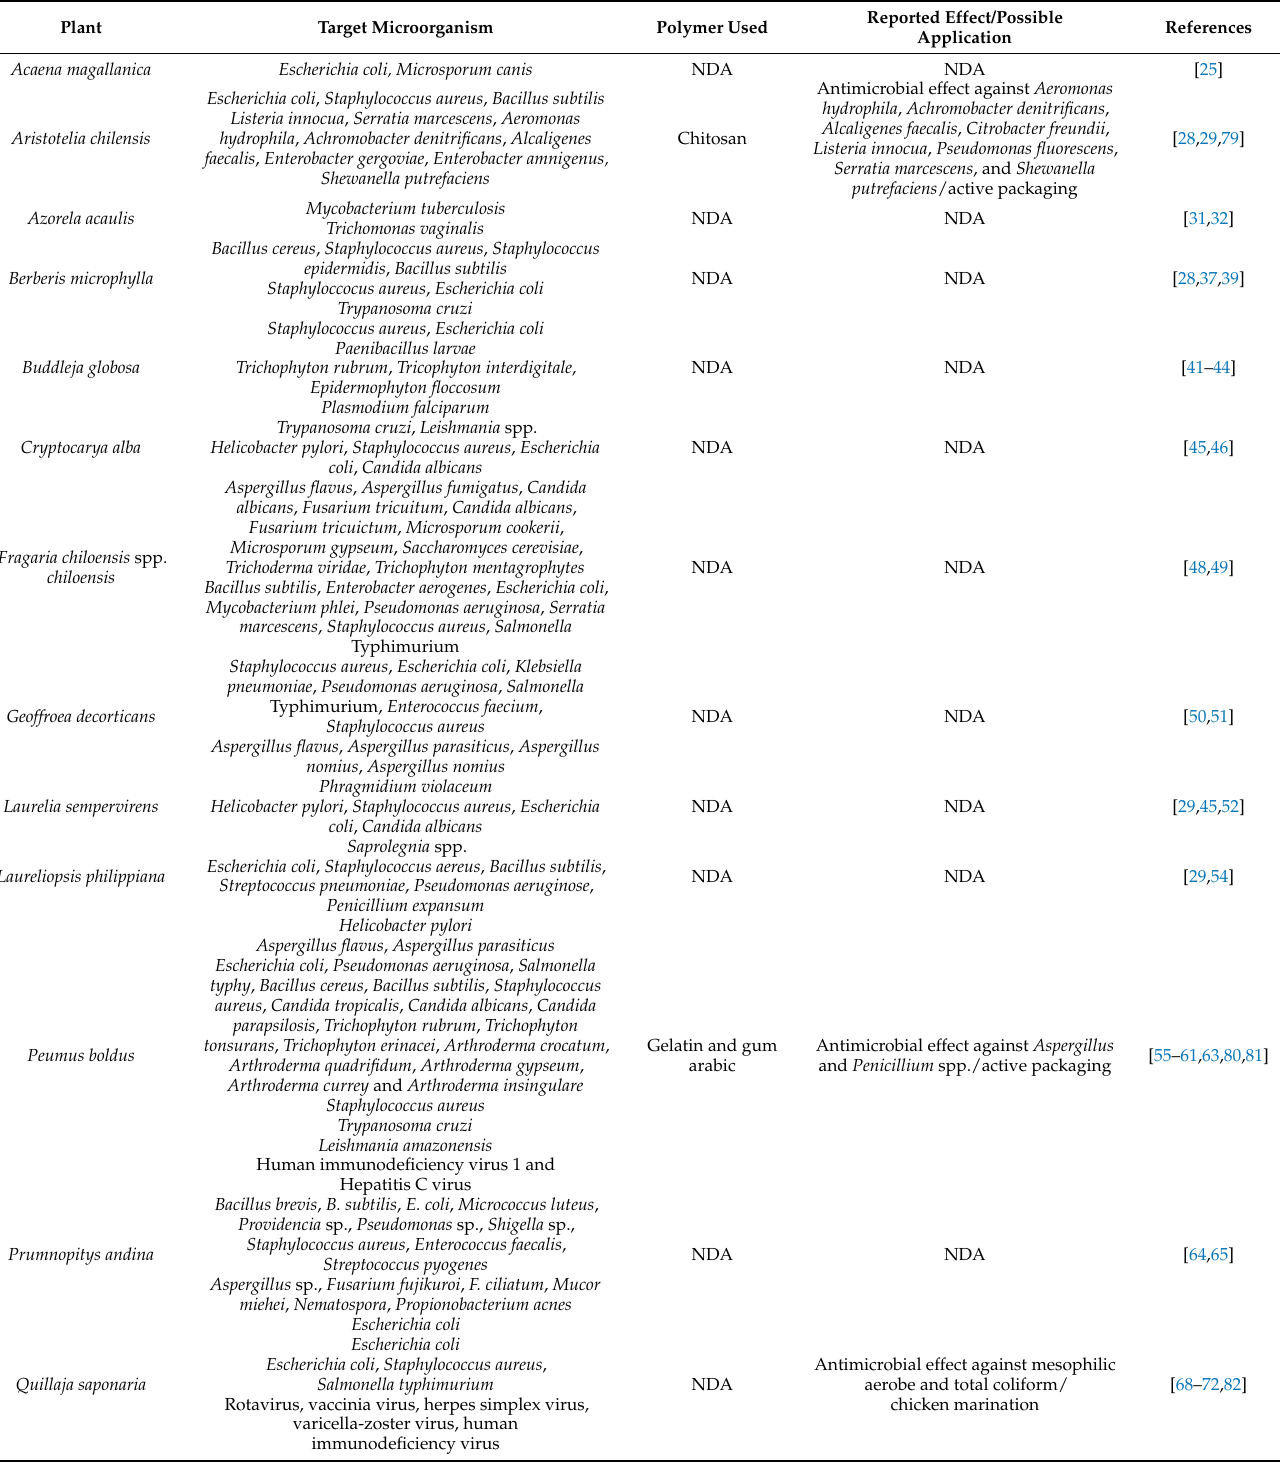
Table 1. Summary of endemic/native plants from Chile involved in antimicrobial activities and their application in food packaging. Information on the polymer used and the proven effect of active films made with extract or chemicals from those species is included when available. NDA: no available